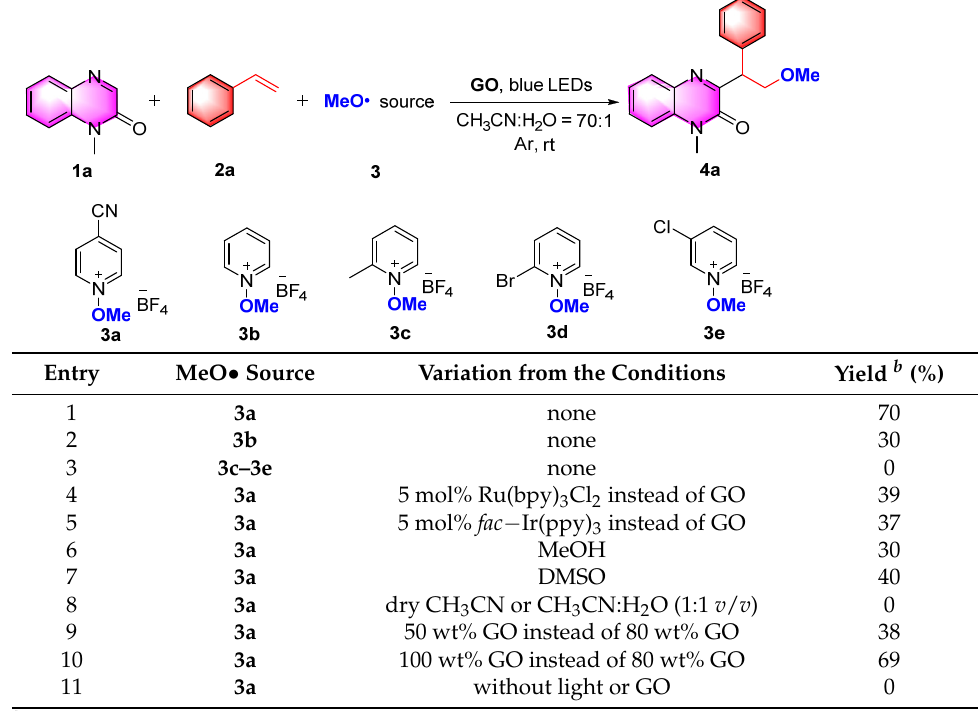
Table 1. Optimization of the reaction conditions a .